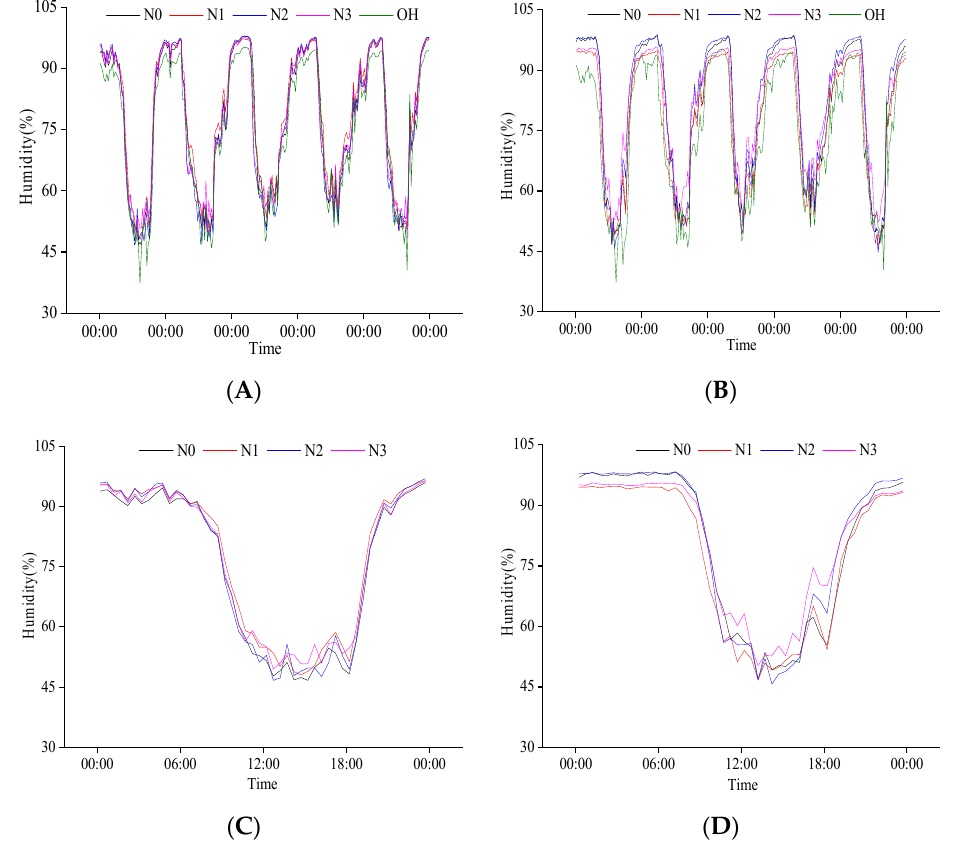
Figure 3. Daily variation in population humidity at the heading stage. ( A ) Canopy humidity of population from 26 July to 30 July; ( B ) Baselayer humidity of population from 26 July to 30 July; ( C ) Canopy humidity of population on 26 July; ( D ) Baselayer humidity of population on 26 July. OH is the change in external humidity, N0, N1, N2, and N3 are the effects of different nitrogen fertilizers on population humidity under P1 conditions.